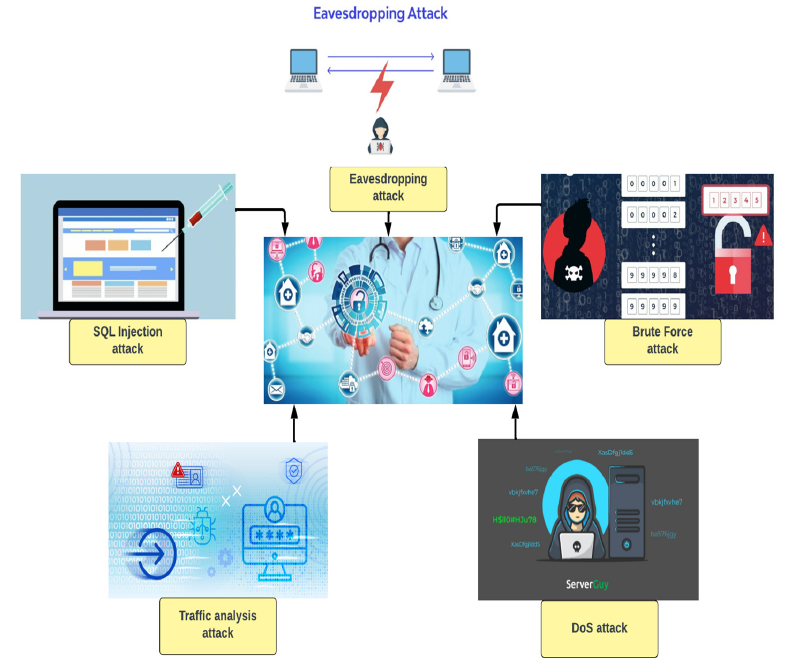
Figure 5. Common attacks of IoMT.